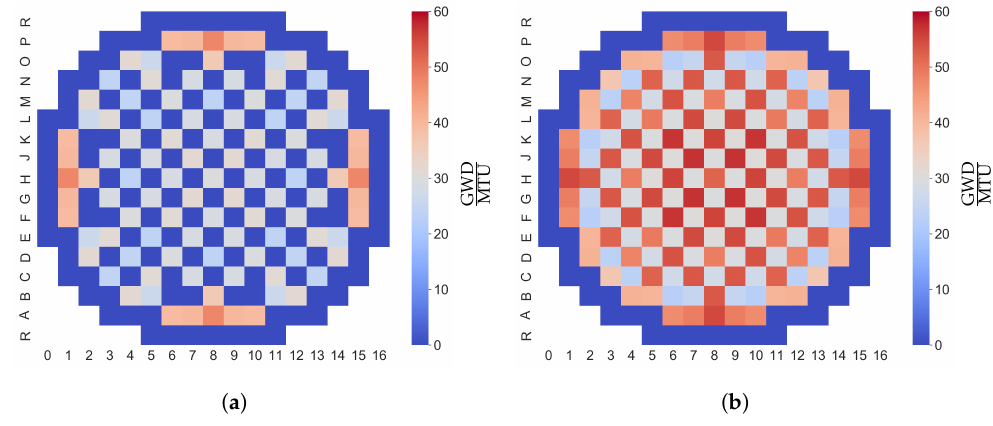
Figure 10. Axially averaged 2D burnup distribution at ( a ) BOC and ( b )